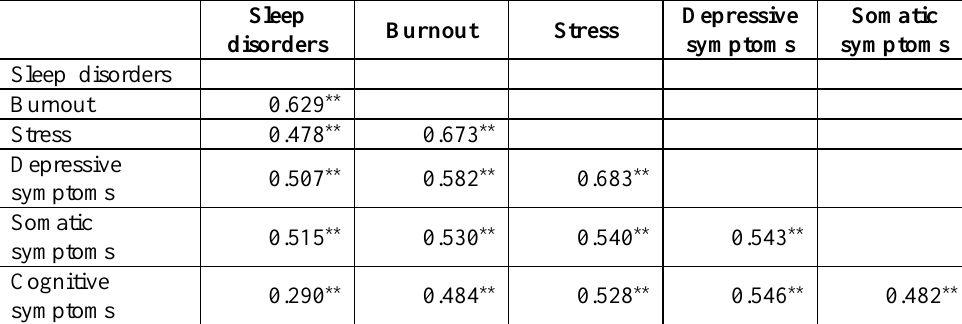
Table 4. Correlation between MHP